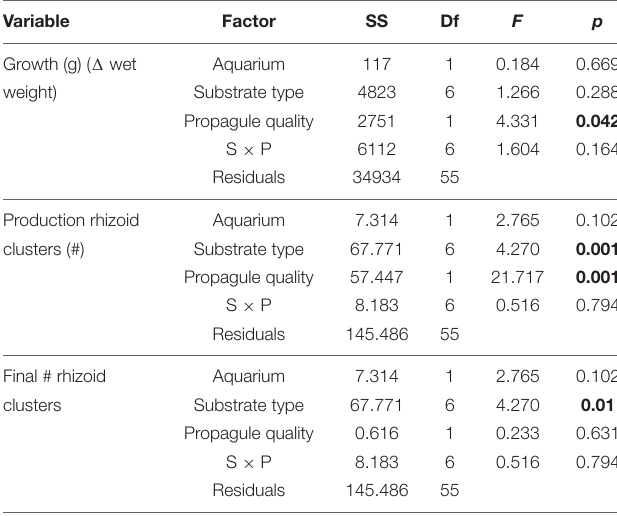
N = 5 propagules per treatment level. Significant p-values are indicated in bold (p <